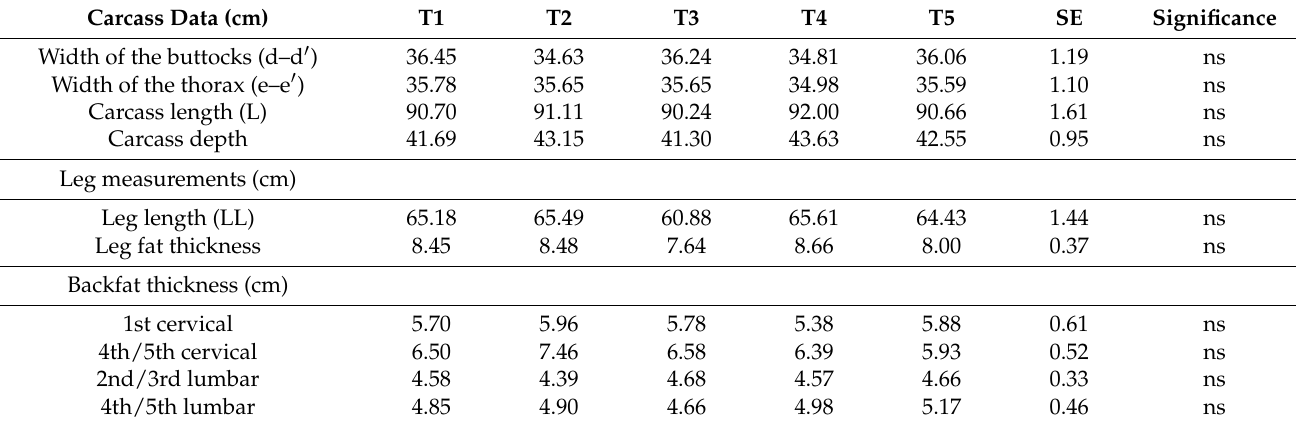
Table 2. Carcass conformation measurements (cm). Effect of treatment with olive cake.